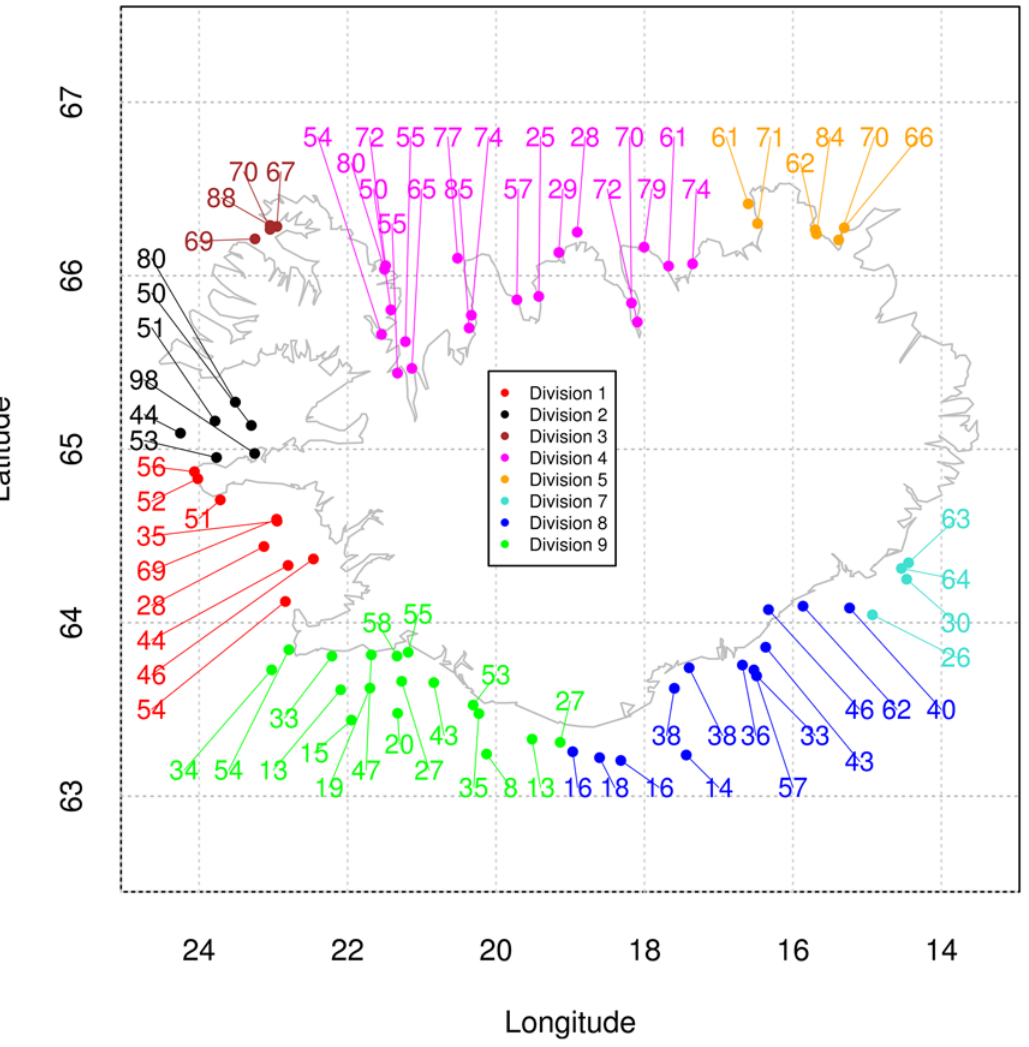
Figure 2. Frequency (percent) of the Pan I A allele in squares within areas. Areas defined by one degree longitude and one half degree latitude (dotted lines) are each split into four equal sized squares (not shown). Sampling stations within subareas are pooled for frequency estimation. Atlantic cod in Icelandic Marine Research Institute spring spawning surveys in 2005, 2006, and 2007. Color coded divisions based on revised METACOD definitions as detailed in paper [19,61].